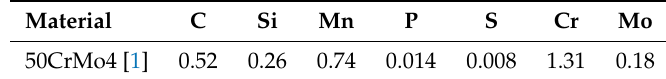
Table 1. Chemical composition of the investigated material 50CrMo4 (SAE4150) in wt.%; the remainder is Fe.